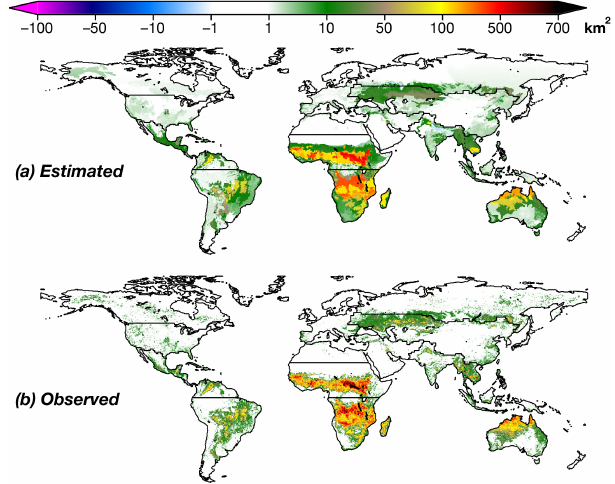
Figure 5. Maps of net mean annual total burned area (km 2 ): (a) esti- mated and (b) observed. Corresponds to Fig. S6 in the